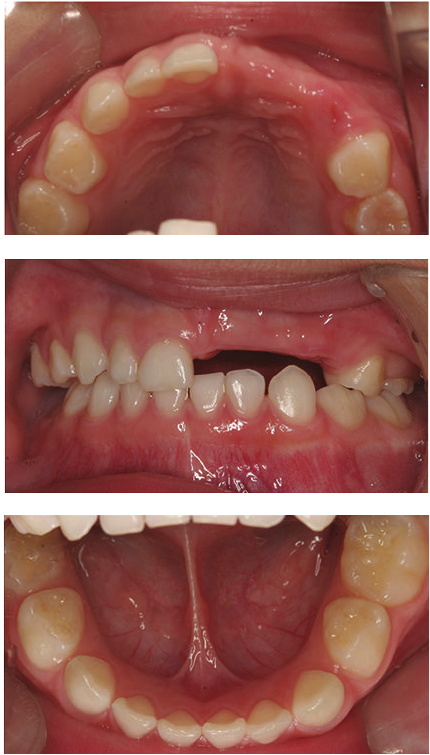
Figure 1: Intraoral findings at initial visit (case 1). An edentulous area is present in the area of the left primary maxillary central incisor, primary maxillary lateral incisor, and primary canine.